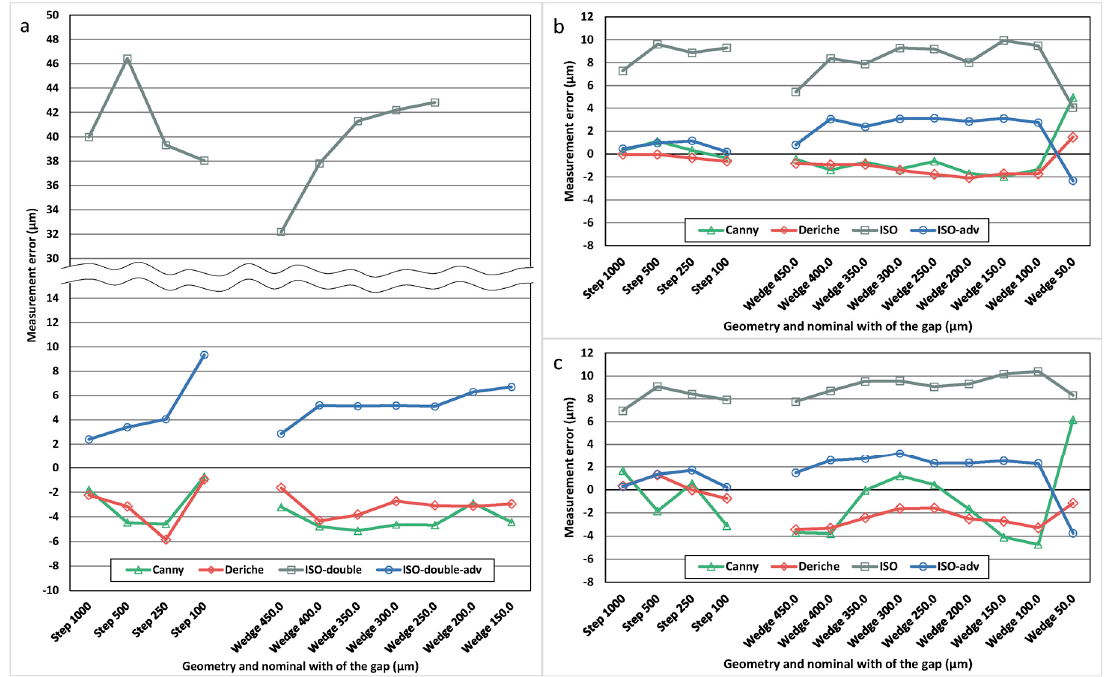
Figure 5. Measurement error results for two surface extraction gradient-based algorithms (Canny and Deriche) and two threshold-based algorithms. The used threshold-based algorithms are ISO-double and ISO-double-adv for the Al / Ti standard ( a ). For Al / Al ( b ) and Al / Cesic ® ( c ), the used threshold-based algorithms are ISO and